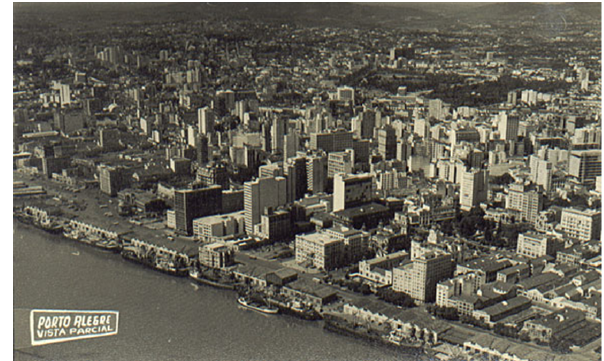
Figure 4. Aerial photography of Porto Alegre in the 1950s (source: Simon,